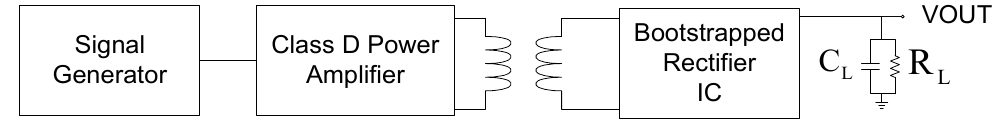
Figure 22. Test system block diagram.